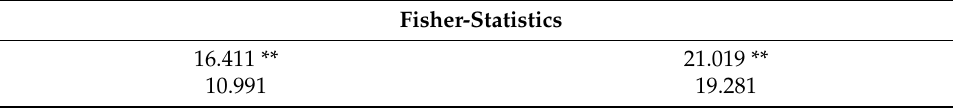
Table 4. Findings of the BH